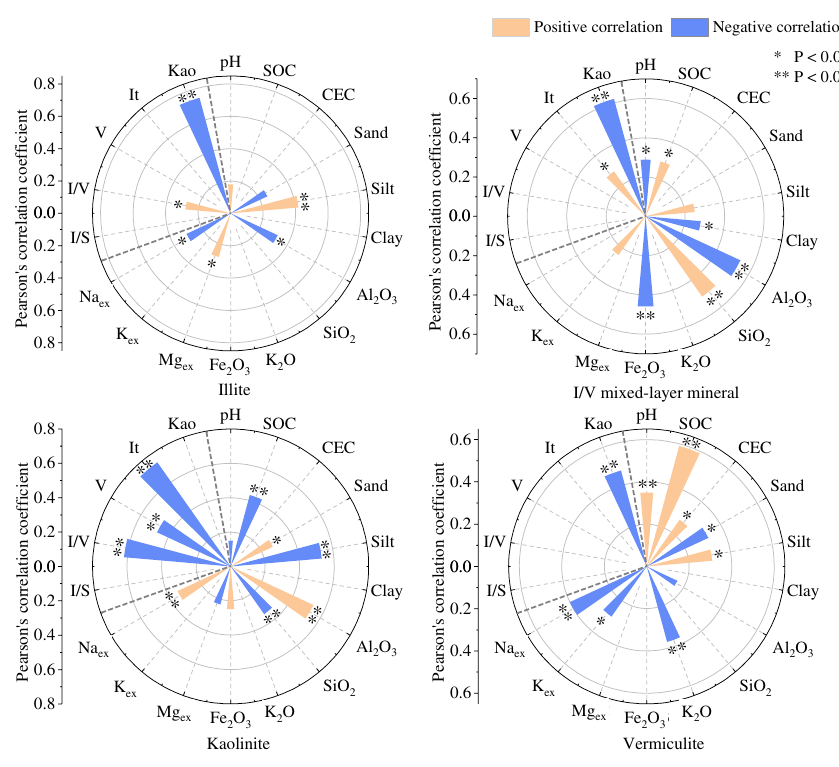
Figure 8. Correlativity of the clay minerals with some physico-chemical properties in studied